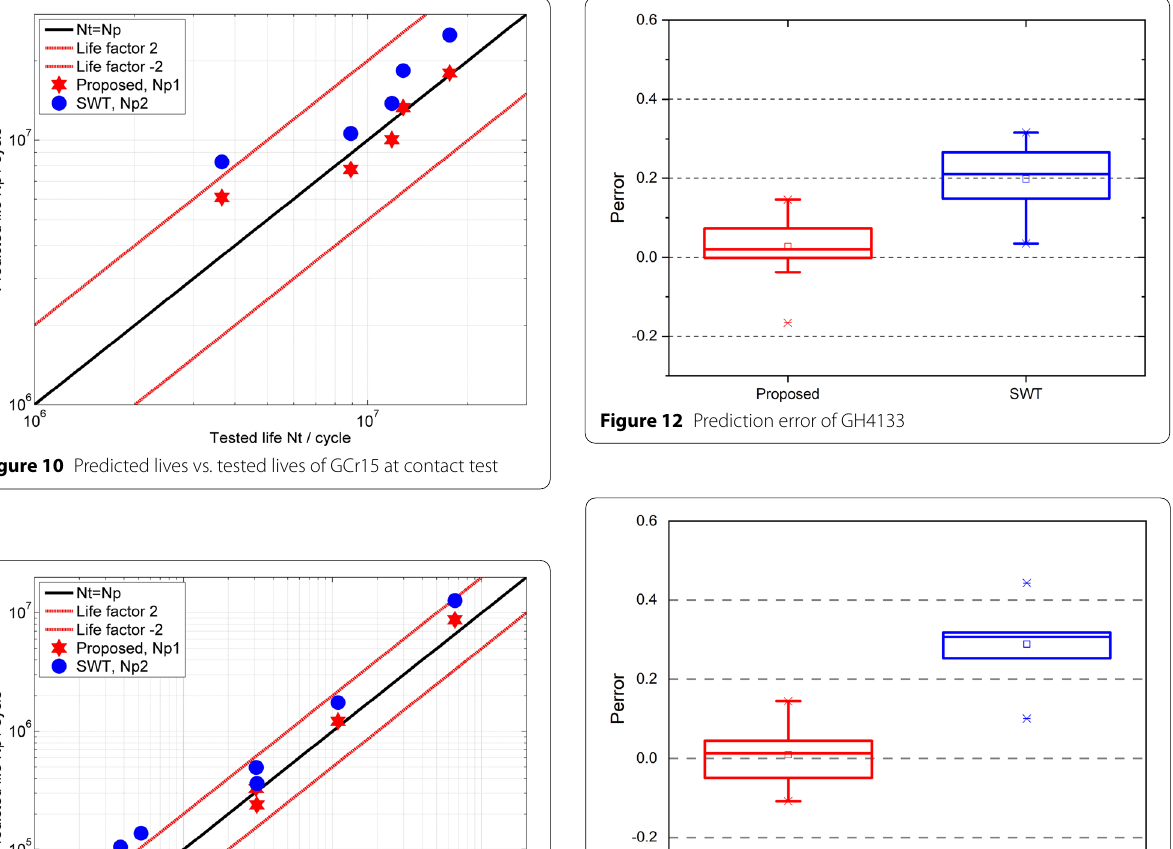
Figure 13 Prediction error of 1Cr11Ni2W2MoV